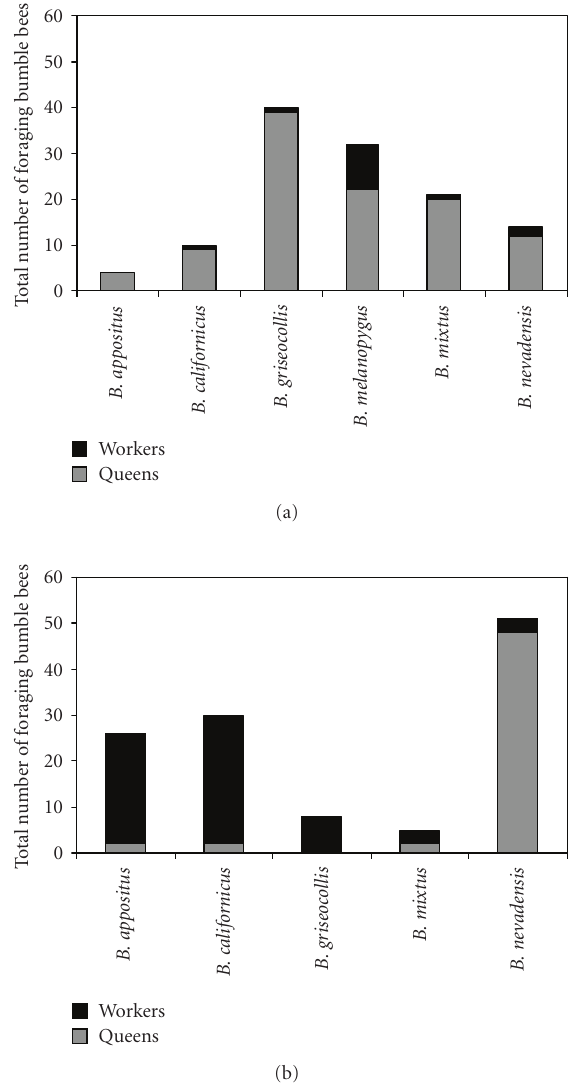
Figure 2: Comparison of the numbers of queens and workers of bumble bee species (excluding B. vosnesenskii which is included in Figure 3) observed foraging on bloom. (a) Blueberries ( n = 127 counts). (b) Red Clover ( n = 187 counts).